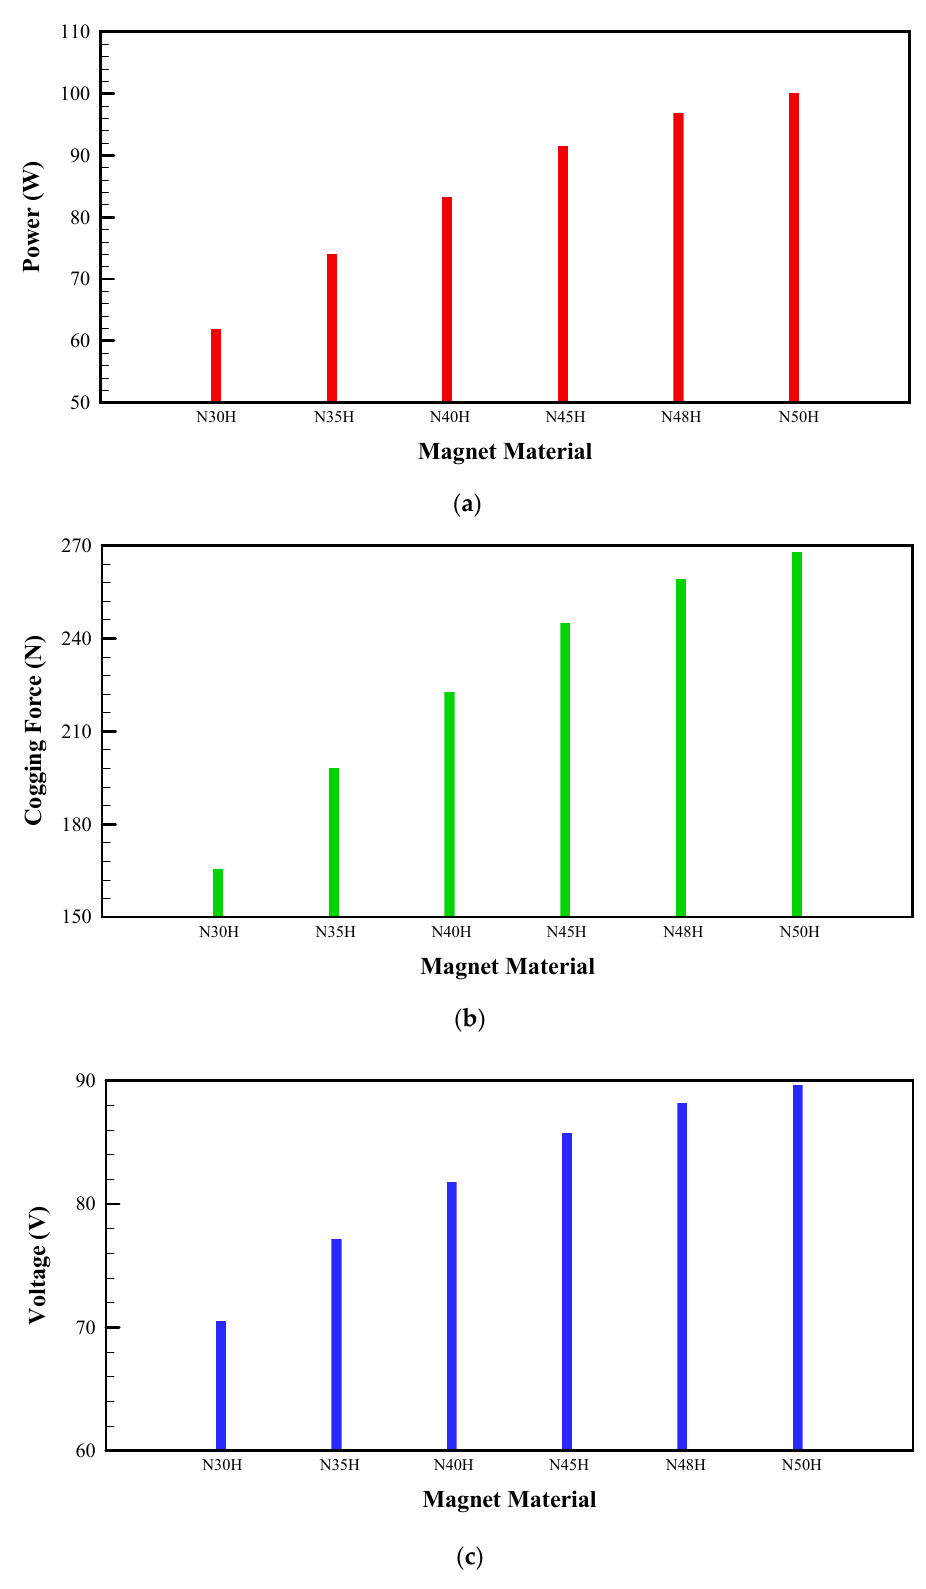
Figure 10. Influence of magnet material on ( a ) induced power, ( b ) voltage, and ( c ) cogging force on the translator.